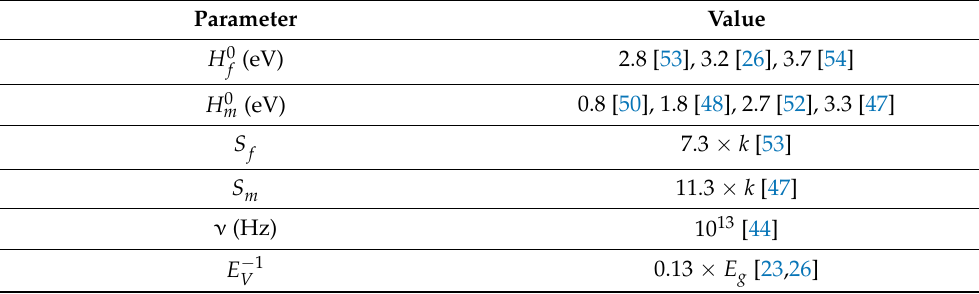
Table 1. Parameters of gallium vacancy in GaAs: formation enthalpy H 0 enthalpy H 0 m and entropy S m , and electron ionization energy in different charged states E − 1 is the Debye